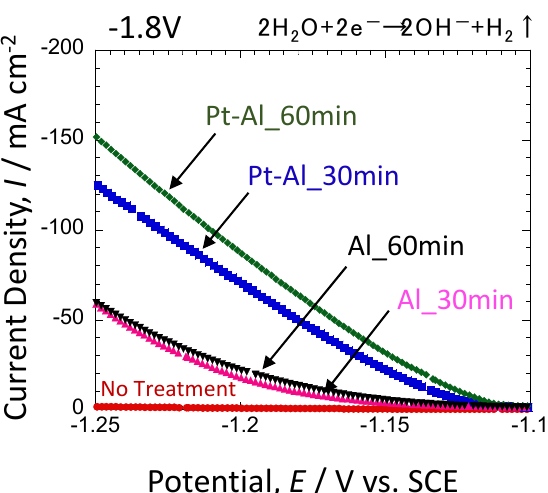
Figure 9. Cathode polarization curve of a sample with a porous surface in a 10 mass% KOH solution.